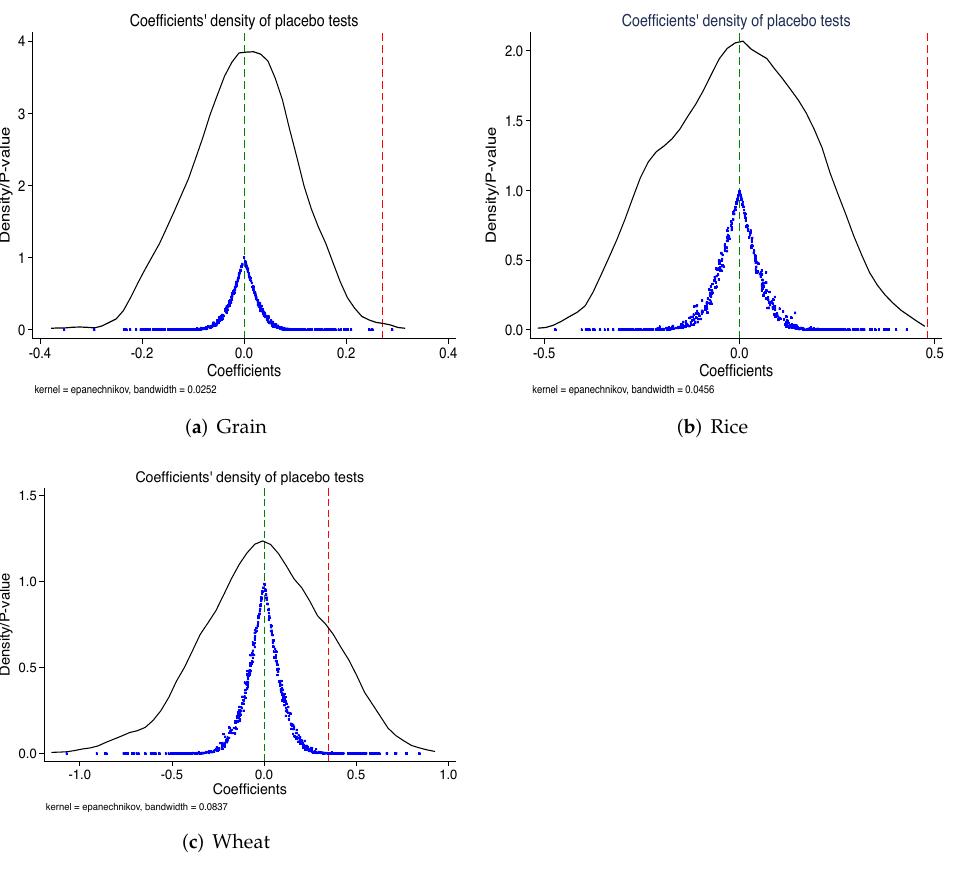
Figure 4. Placebo